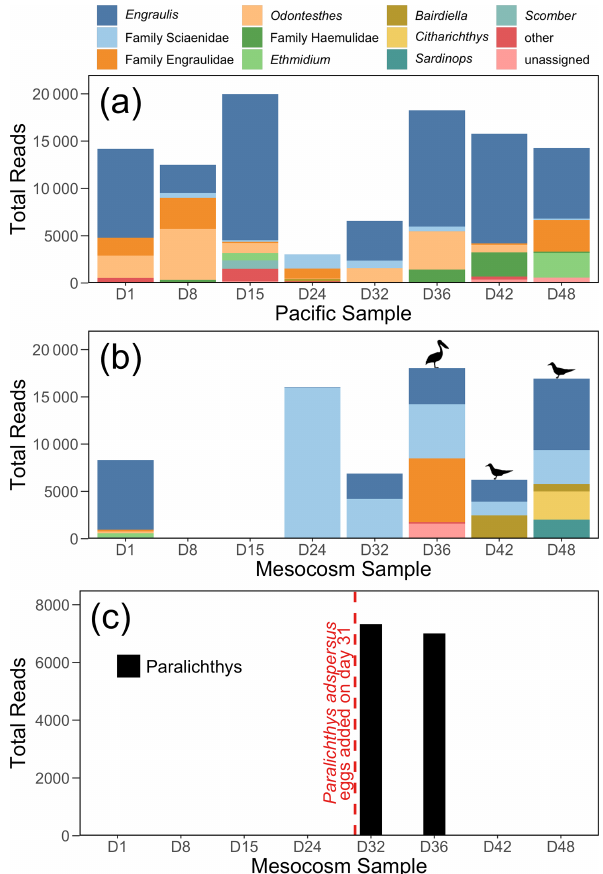
Figure 4. The 12S rRNA results, showing top 10 genera (or fam- ilies, for ASVs that were not annotated to the genus level) for (a) the Pacific and (b) the mesocosm samples, by total number of reads. Detections of Larosterna inca and Pelecanus occidentalis are indi- cated by the symbols in (b) . All reads of Paralichthys have been re- moved from (a) and (b) . Panel (c) shows the total number of reads of Paralichthys , the genus of the fish eggs ( Paralichthys adsper- sus ) that were added to the mesocosm on day 31. Because there is no available reference sequence for Paralichthys adspersus , genus- level annotations are used to assess the detections of this species using